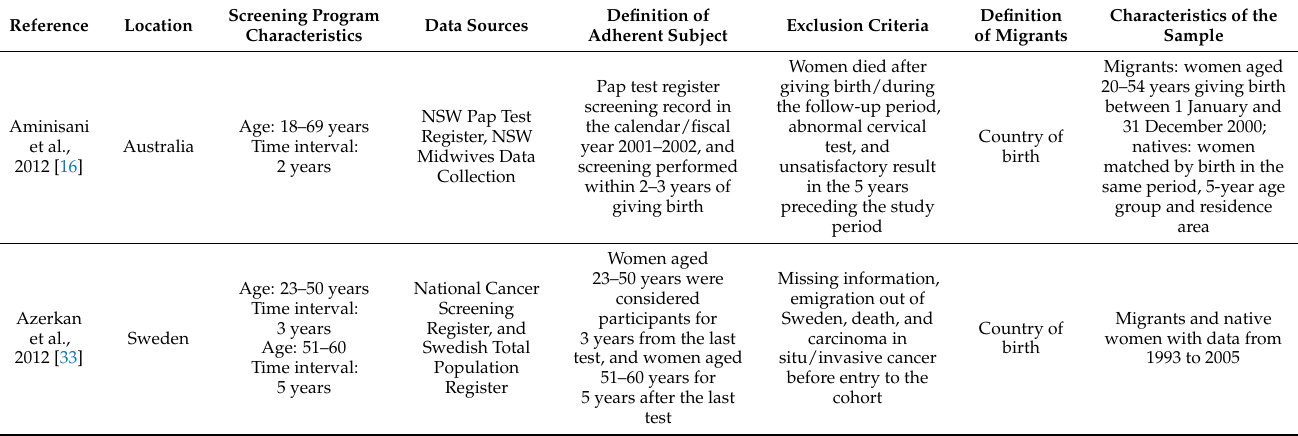
Table 2. Characteristics of the included studies.